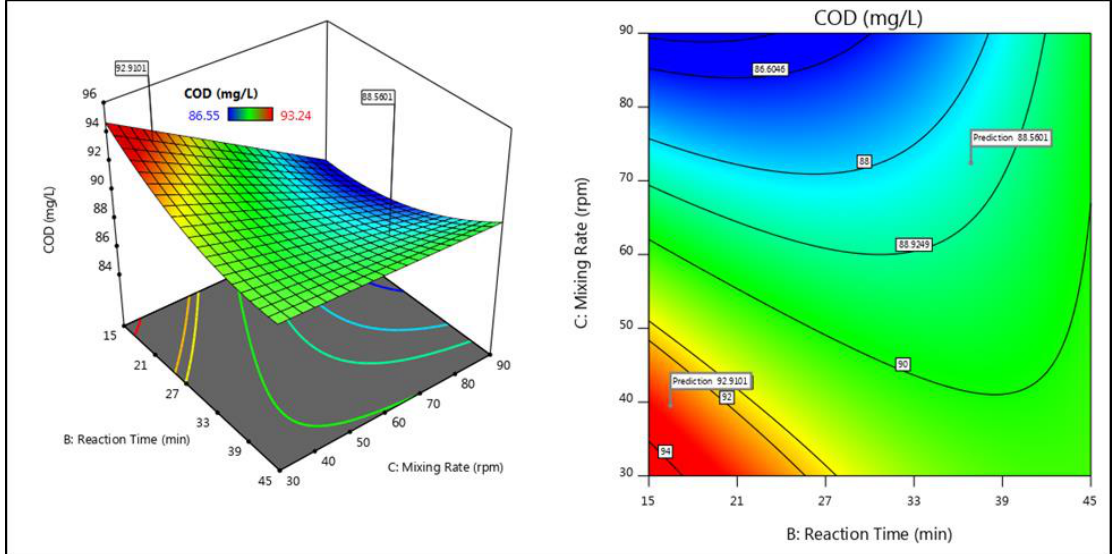
Figure 4. 2D and 3D plots representing the cross factor interactive e ff ects of the interaction between reaction time and mixing rate (BC) on COD removal by zeolite.